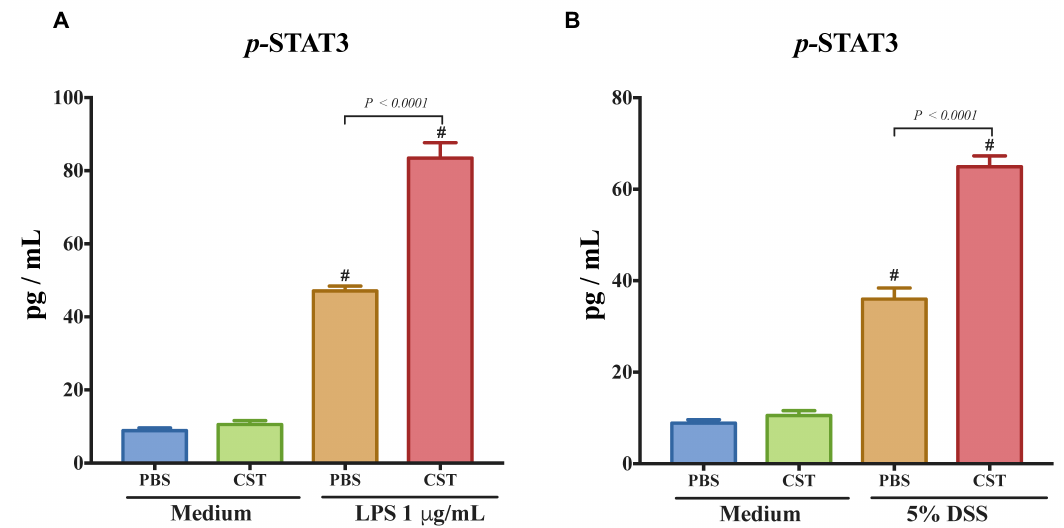
Figure 6. Catestatin (CST) induces the phosphorylation of signal transducer and activator of transcription 3 (STAT-3) in lipopolysaccharide (LPS)- and dextran sulfate sodium (DSS)-stimulated colonic epithelial cell lines. Caco-2 cells were treated with 1 × phosphate buffer saline (PBS) or CST (100 ng/mL) in medium for 24 h then challenged with LPS (1 µ g/mL) or 5% dextran sulfate sodium (DSS) for additional 24 h. ( A , B ) p-STAT3 levels in LPS- and DSS-stimulated epithelial cells. One-way ANOVA was used to analyze the data followed by multiple comparison tests. Data represent mean ± SEM ( n = 6–9). # Compared to control medium groups. Each experiment was repeated at least three